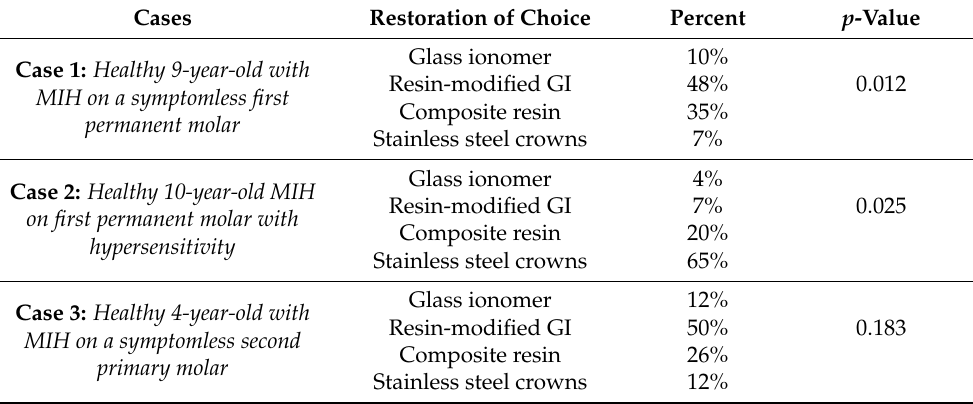
Table 2. Residents’ preferable restorative materials to manage cases with